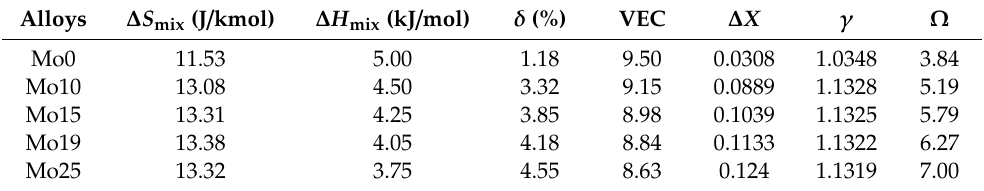
Table 2. Parameters ∆ S mix , ∆ H mix , δ , VEC, ∆ X, Ω for the (CoCuFeNi) 100- x Mo x high entropy alloys. Table 2. Parameters ΔS mix , ΔH mix , δ , VEC, ΔX, Ω for the (CoCuFeNi) 100- x Mo x high entropy alloys Alloys ∆ S mix (J / Alloys Δ S mix (J/kmol) Δ H mix (kJ/mol)